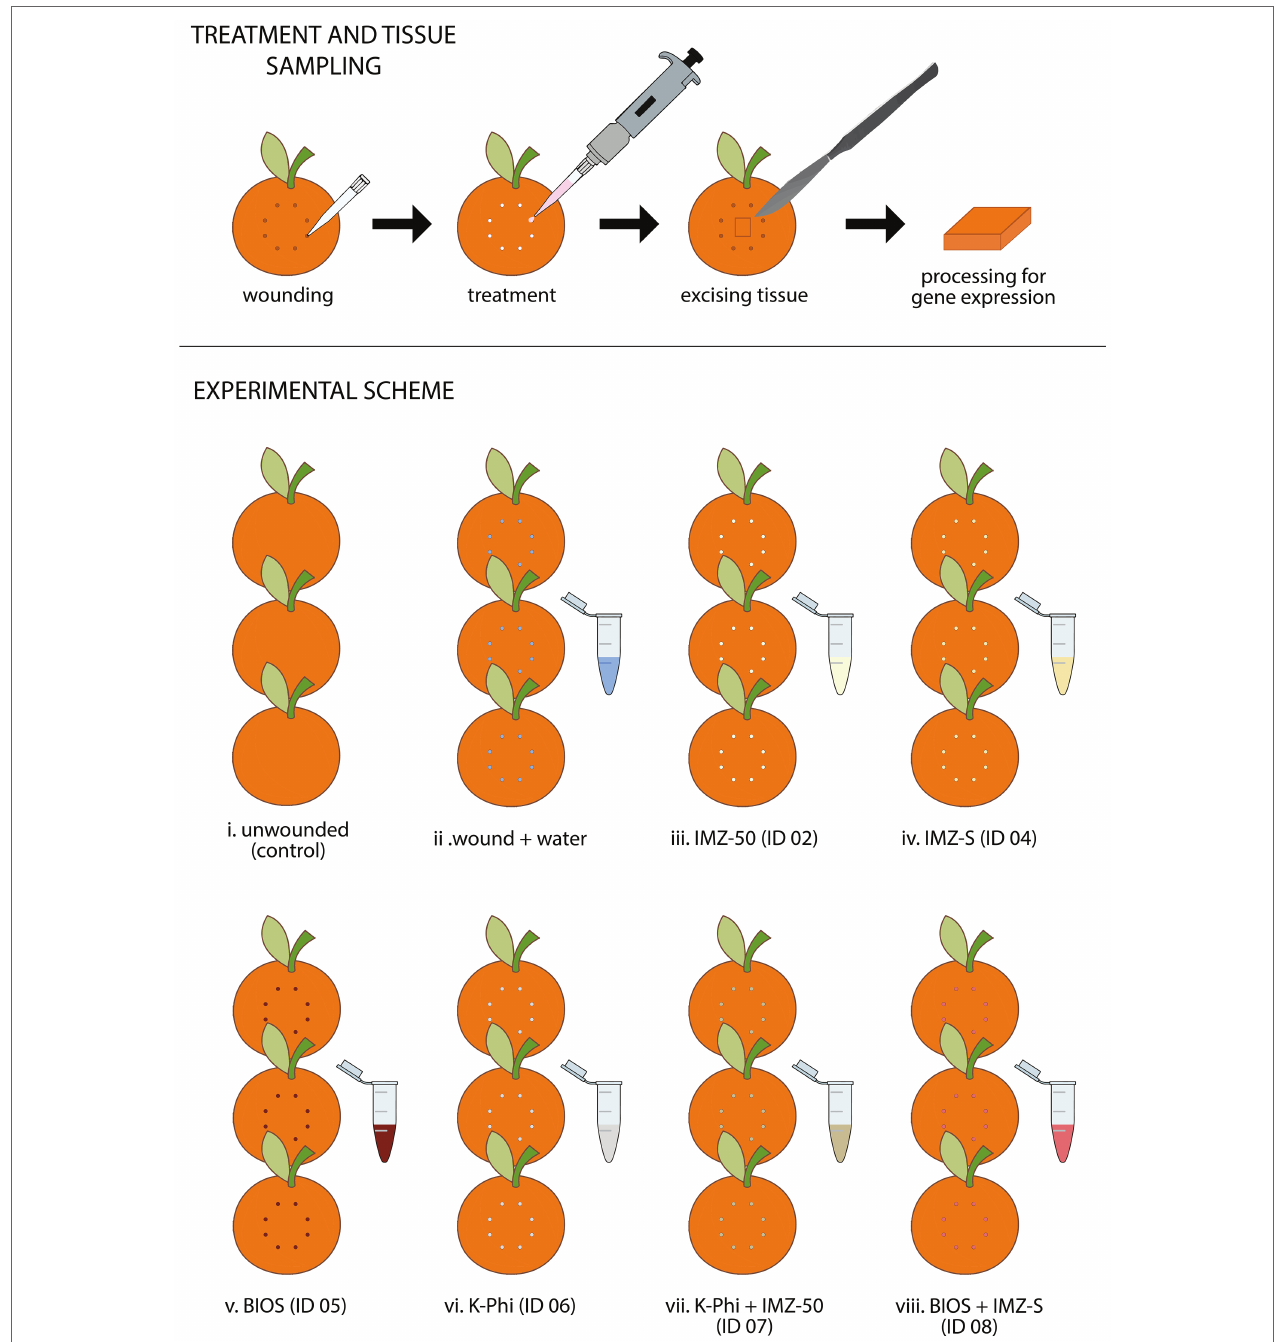
FIGURE 2 | Summary of the experimental procedure and scheme employed for studying the effectiveness of test substances in triggering the differential expression of genes involved in the induction of resistance mechanisms in citrus